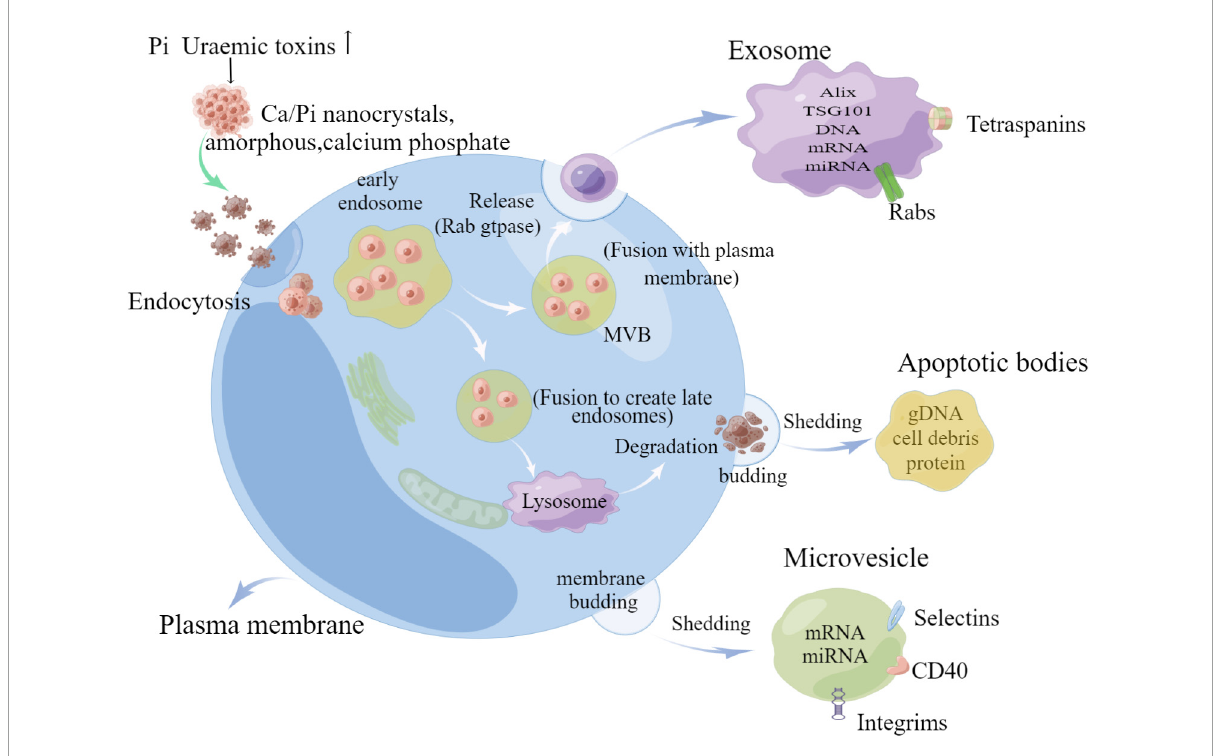
FIGURE2 Schematic diagram of extracellular vesicle release (by Figdraw).